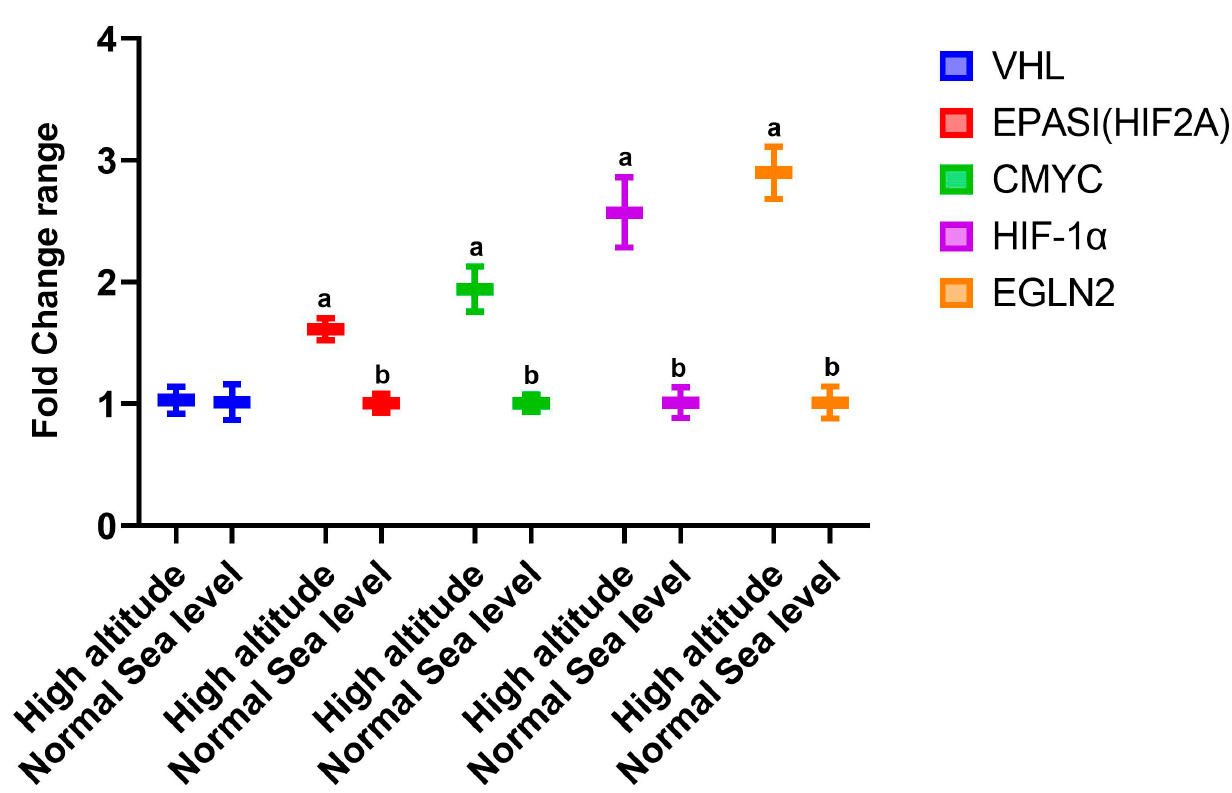
Figure 2. Impacts of high altitude on the expression levels of renal oxidative stress marker genes associated with hypoxia in the kidneys as assessed using quantitative real-time PCR. Bars indicate densitometric analysis of the expression levels of the examined genes for 10 different rats per group. Bars with different letters indicate significant differences between groups A (normal sea level) and B (high altitude) at p < 0.05.